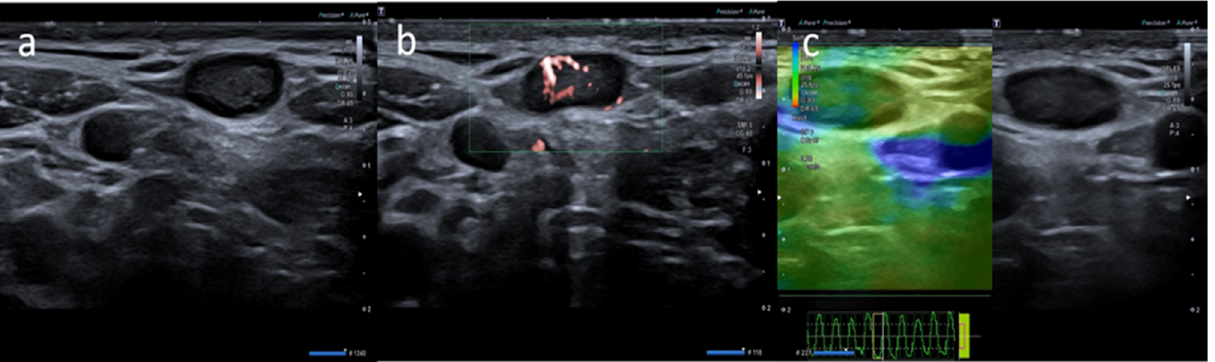
Figure 1. A 20-year-old male with palpable unilateral subclavicolar adenopathy noted three days after receiving the first dose of the Moderna COVID-19 vaccine in his left deltoid muscle. ( a ) B-mode sonogram image shows two ovalar hypoechoic lymph nodes with symmetric cortical thickening and hilum evidence. ( b ) SMI image shows central and peripheral vascularization. ( c ) Elastosonography strain shows a similar pattern of the node compared surrounding tissue.